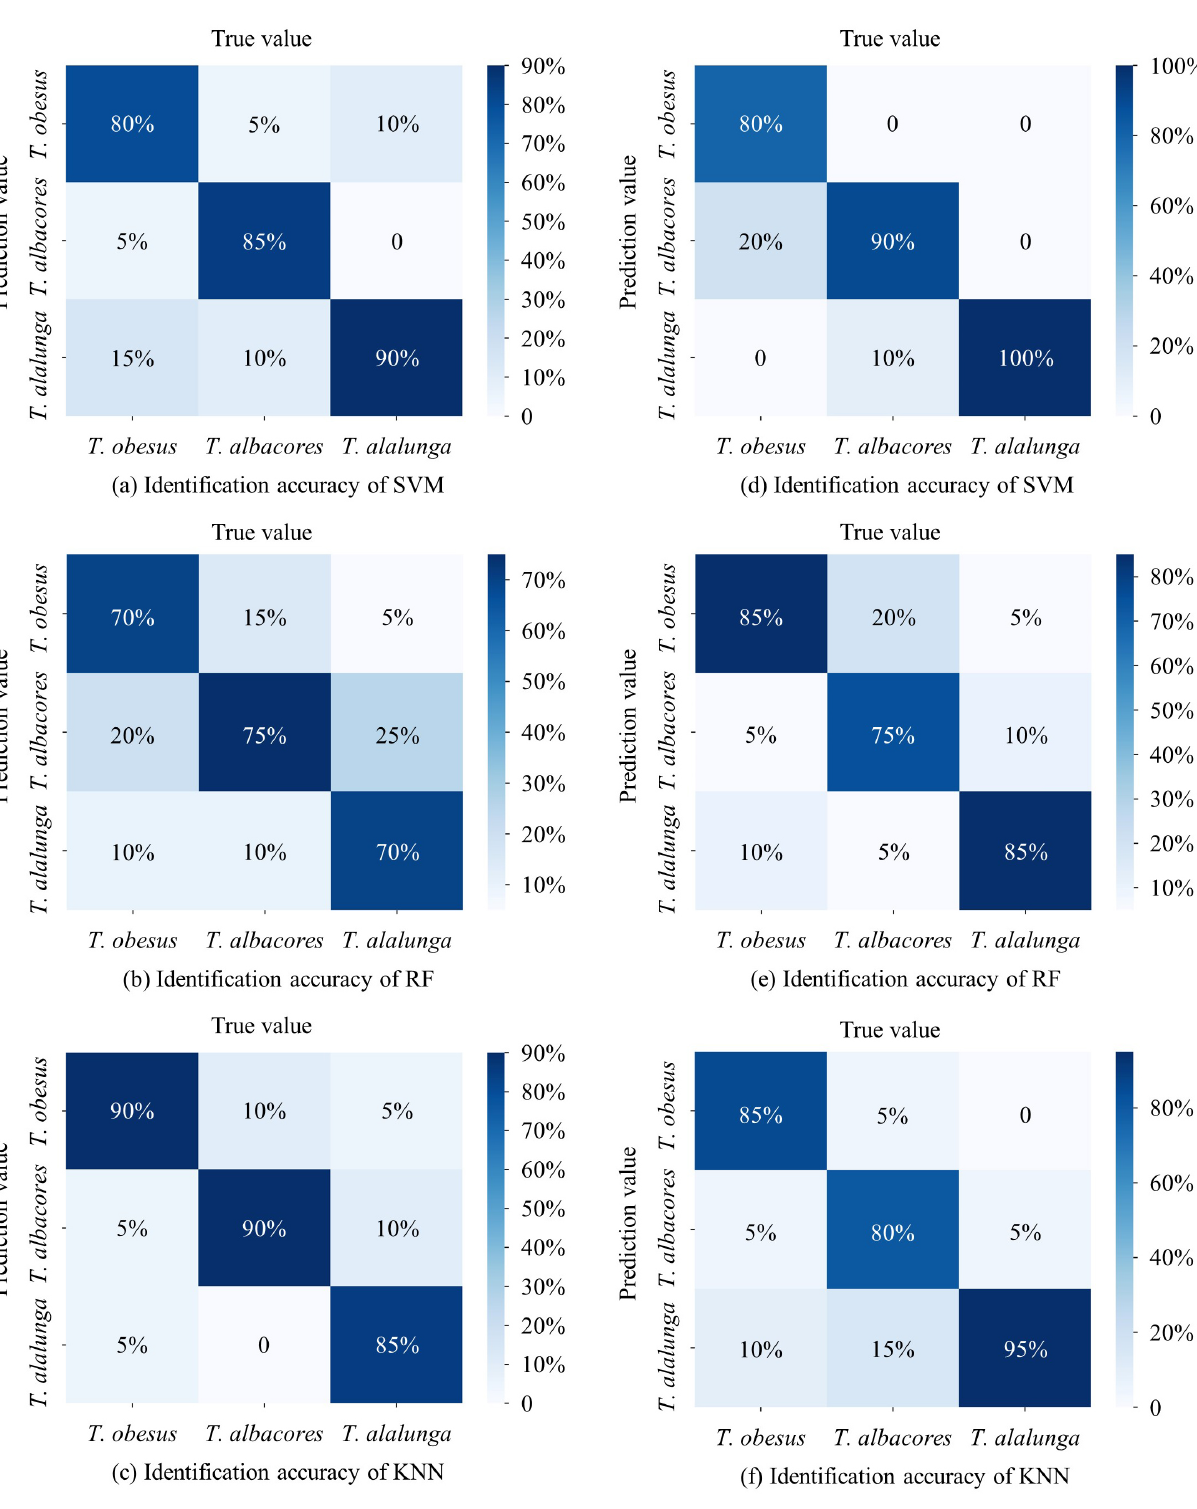
Figure 9. Identification accuracy of different machine learning algorithms in Thunnus species: from ( a ) to ( c ) is the confusion matrix of the EFT features; from ( d ) to ( f ) is the confusion matrix of the deep features; ( a ) and ( d ) represent SVM; ( b ) and ( e ) represent RF; ( c ) and ( f ) represent KNN.